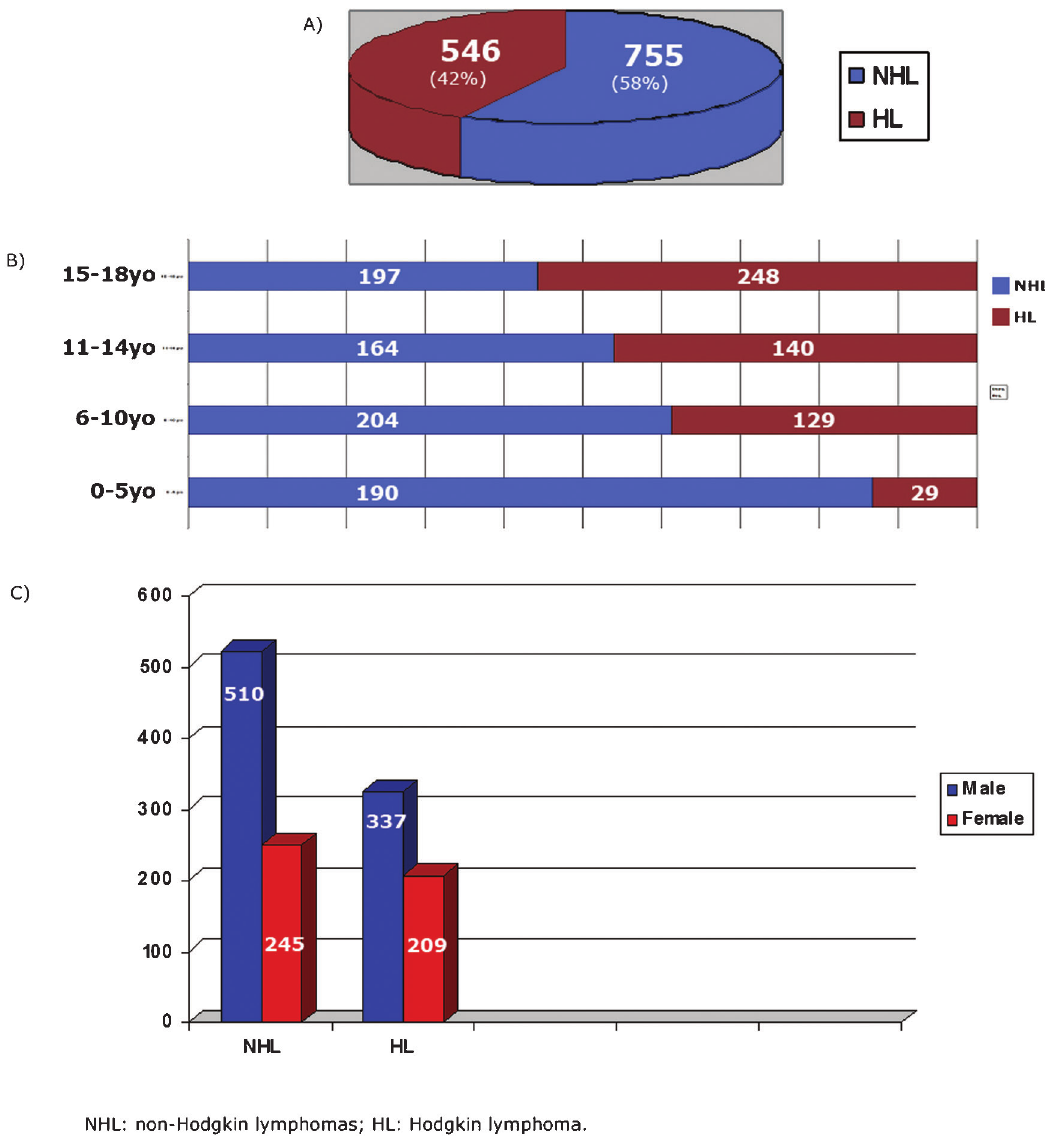
Figure 1 – A, Global distribution of non-Hodgkin and Hodgkin pediatric lymphoma cases in Brazil. B, Distribution of all cases of pediatric lymphoma by age groups. C, Distribution of all cases of pediatric lymphoma by